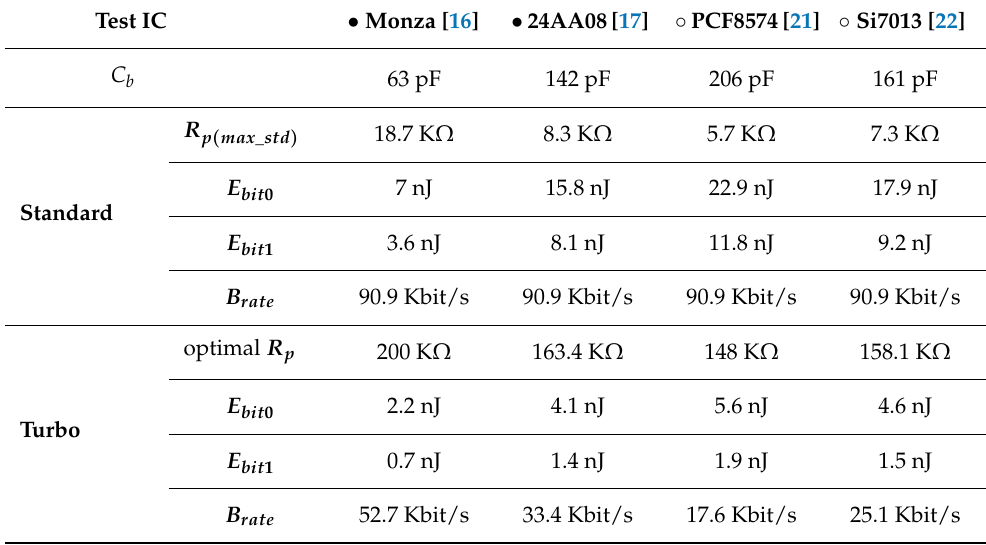
Table 1. Experiment parameters in the evaluation and the comparison between the standard and Turbo . The symbol “ • ” represents the IC with the Schmitt trigger, while the symbol “ ◦ ” indicates the IC without the Schmitt